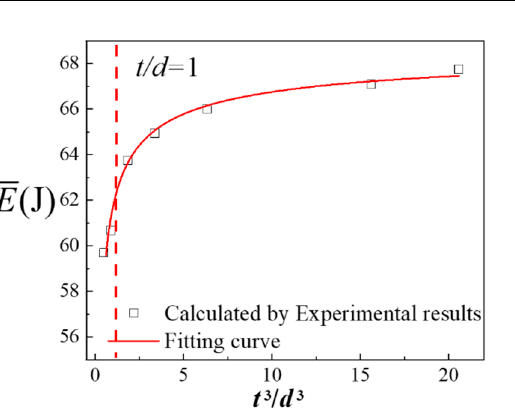
Figure 8. Optimized n p value based on the new model.